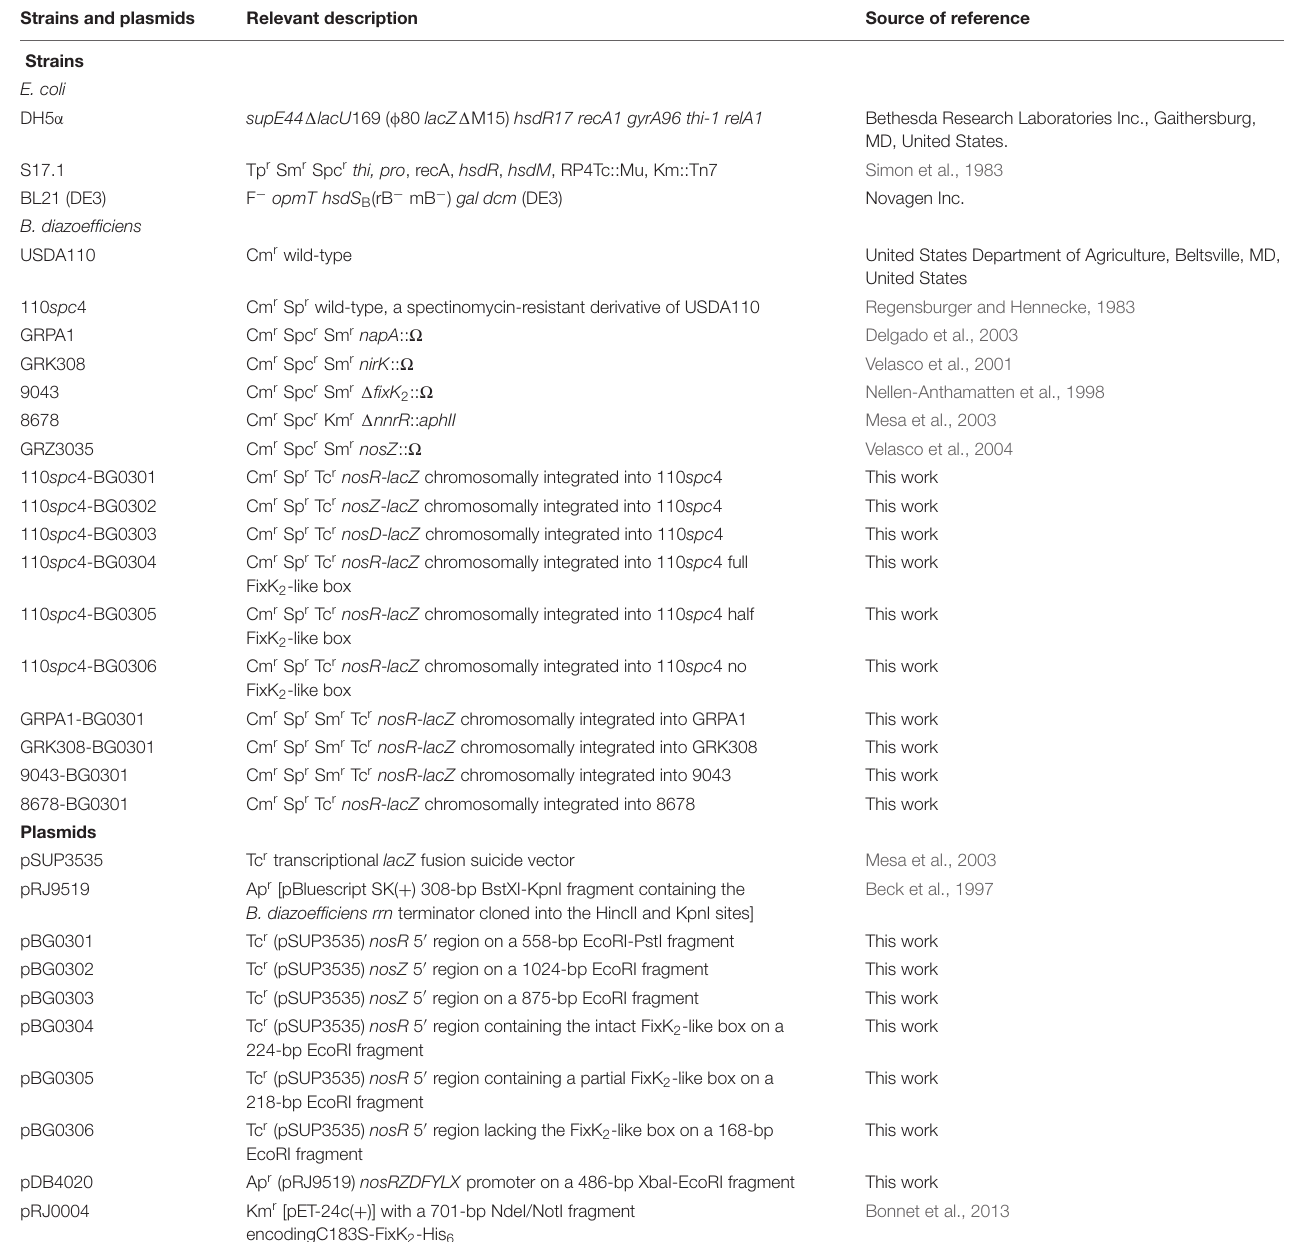
TABLE 1 | Bacterial strains and plasmids used in this